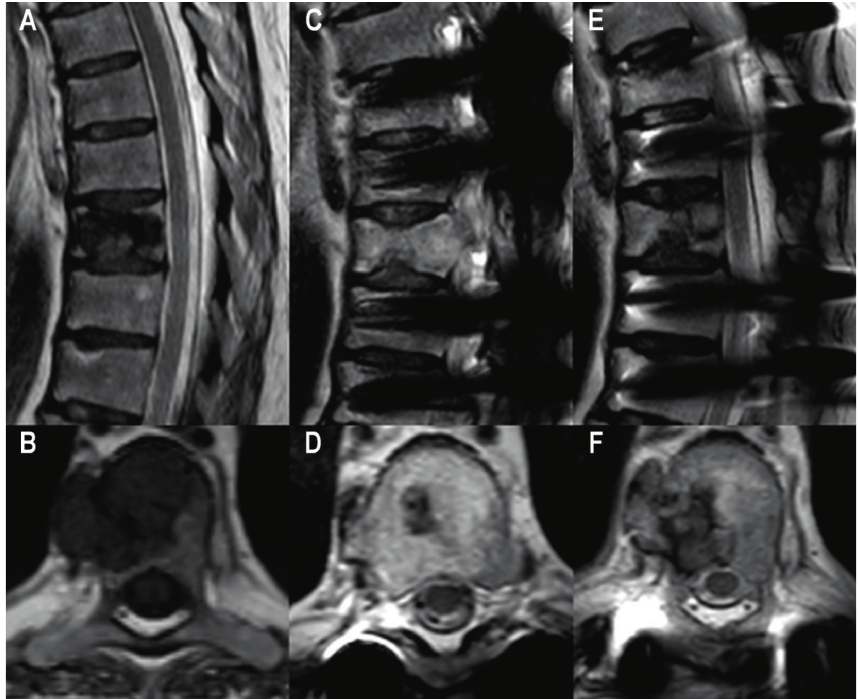
Figure 1: Spine MRI. (a, b) Sagittal T2 weighted Dixon in-phase and axial T1 weighted sequences from initial spine MRI showing tumor in the body of Th8. (c, d) Sagittal T2 weighted Dixon in-phase and axial T2 weighted sequences performed 19 months later showing spondylodesis and partial regression of tumor. (e, f) Sagittal and axial T2 weighted sequences performed additionally 33 months later showing progression of tumor.